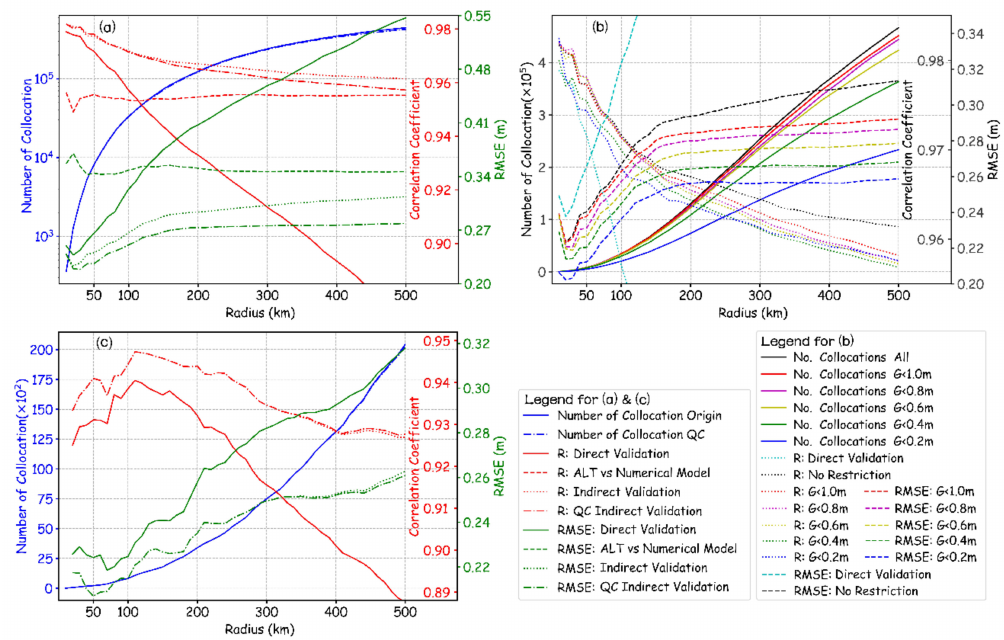
Figure2. The N col , correlationcoe ffi cient(CC),androot-mean-square-error(RMSE)ofEnvisatsignificant wave heights (SWHs) versus buoy SWHs as a function of the radius of the spatial window. In subplot ( a ), each color represents a parameter and each type of line represents a type of validation: blue, green, and red lines represent N col , RMSE, and CC, respectively; the solid, dotted, dot-dashed, and dashed lines represent the results of direct validation, indirect validation without and with a quality control (QC) of G < 0.6 m, and the direct comparison between IOWAGA and Envisat SWHs, respectively. In subplot ( b ), each color represents a QC standard for indirect validation and each type of line represents a specific type of validation: The solid, dashed, and dotted lines represent N col , RMSE, and CC, respectively; the cyan, black, and other color lines represent the results of direct validation, indirect validation without QC, and indirect validation after a QC with di ff erent values of G . Subplot ( c ) is the same as ( a ), but only the data from buoy 32,012 was